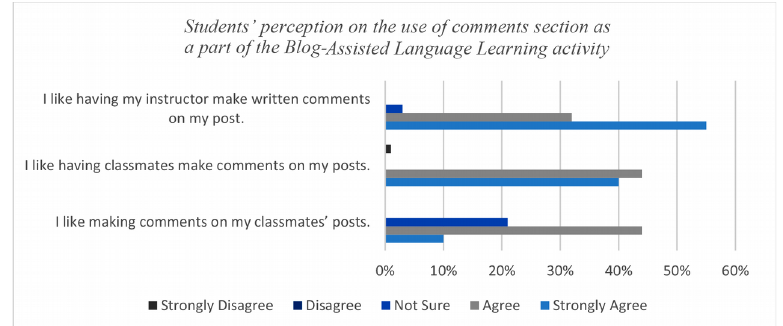
Figure 2. Students’ perception on the use of comments section as a part of the Blog-Assisted Language Learning